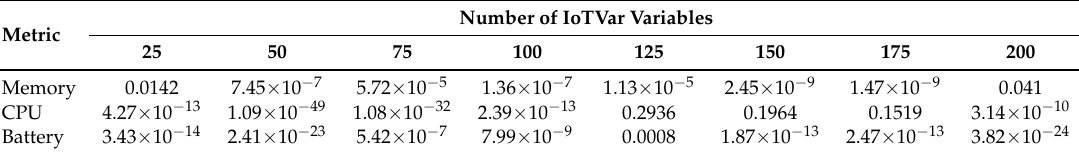
Table 1. p -values from the t -test for the synchronous